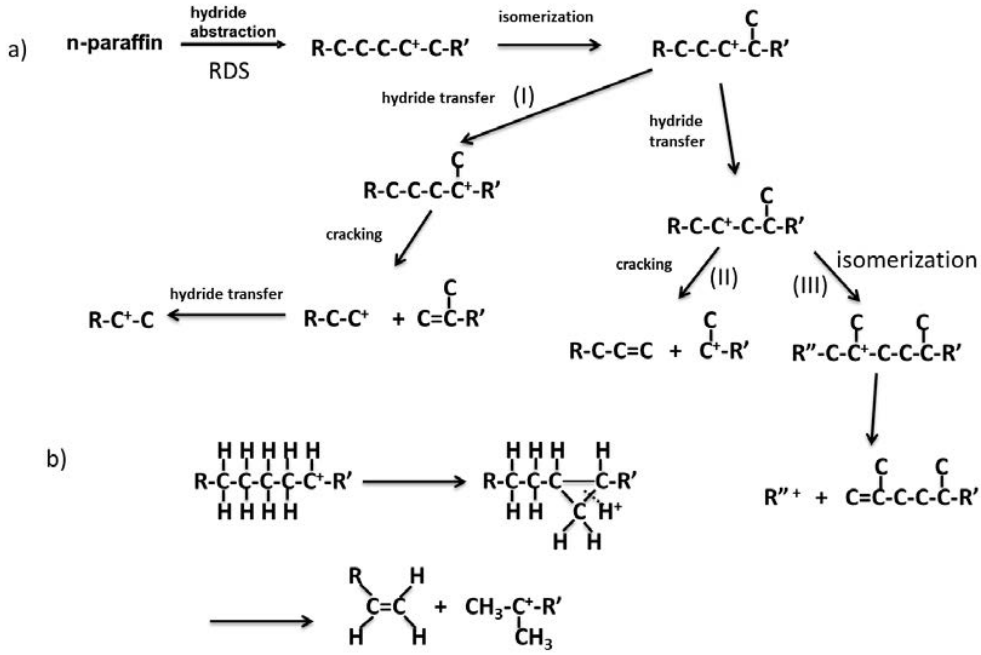
Figure 14. Reaction pathway of carbenium ion in catalytic cracking of n